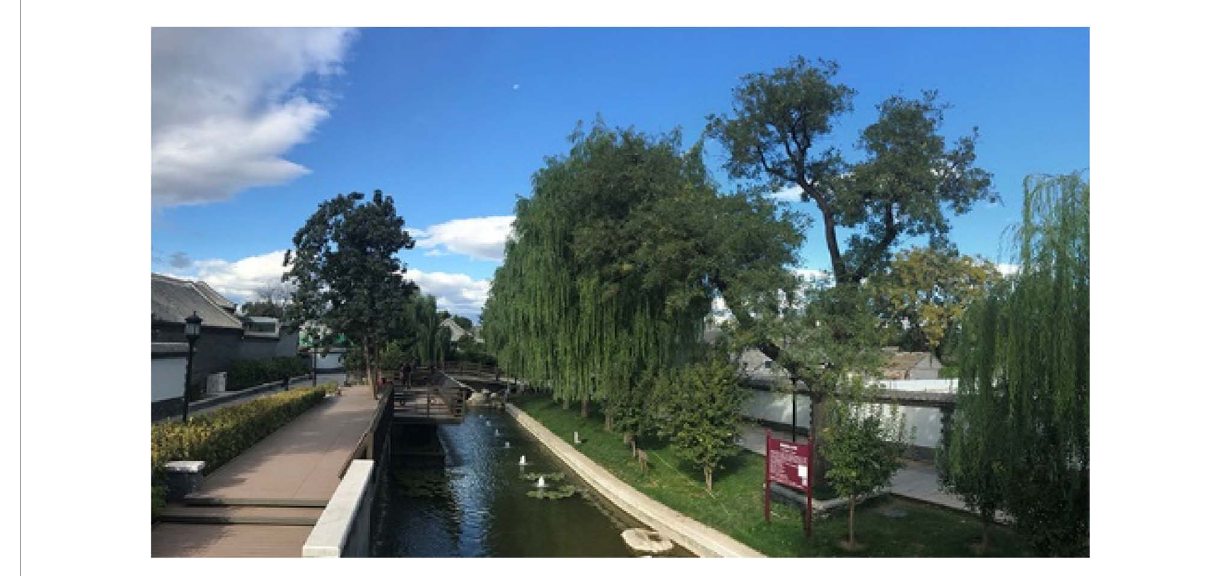
FIGURE12 The heritage site of the daylighted section of the Yuhe River (Fan and Da,